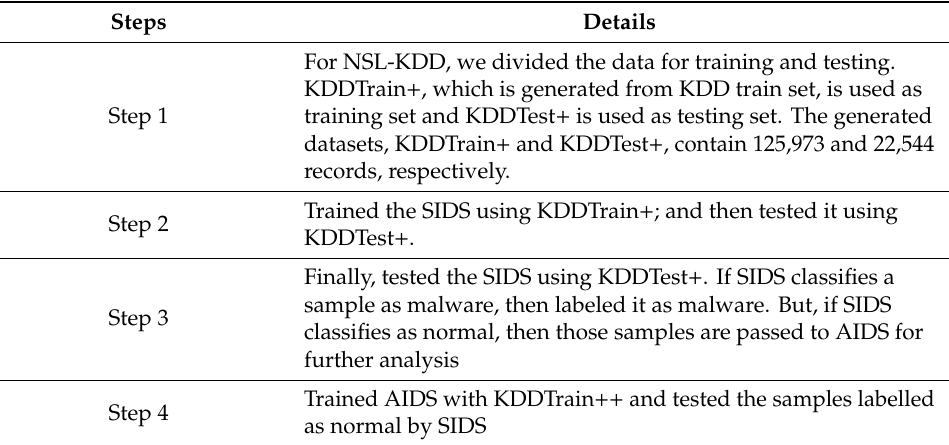
Table 7. Steps followed for training and testing the NSL-KDD dataset.